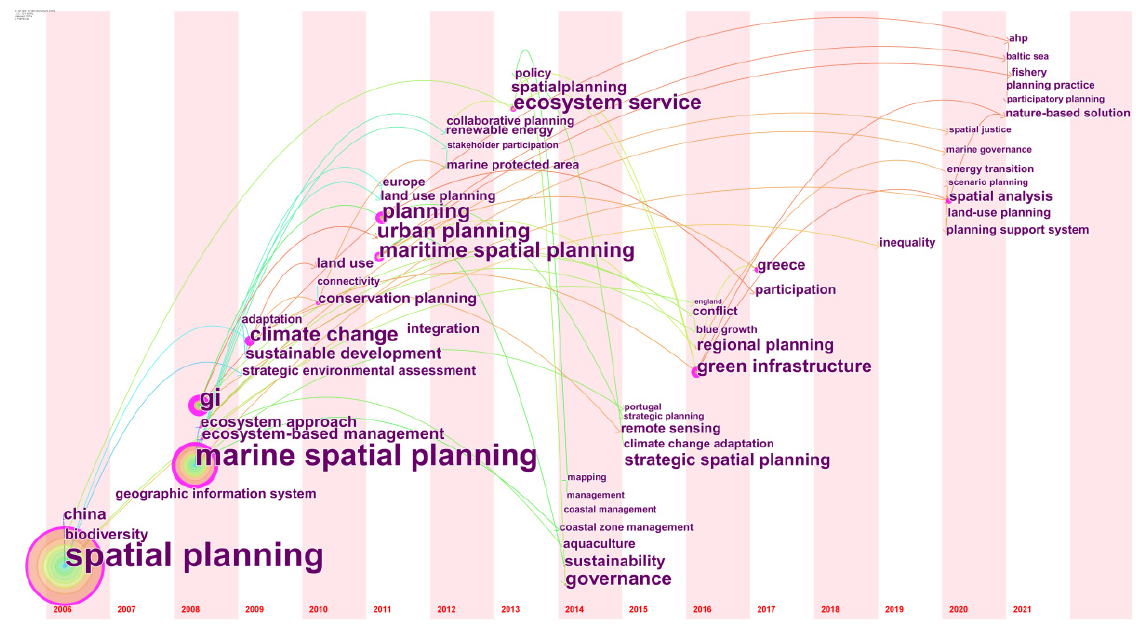
Figure 8. Visualization of time zone (WOSCC).